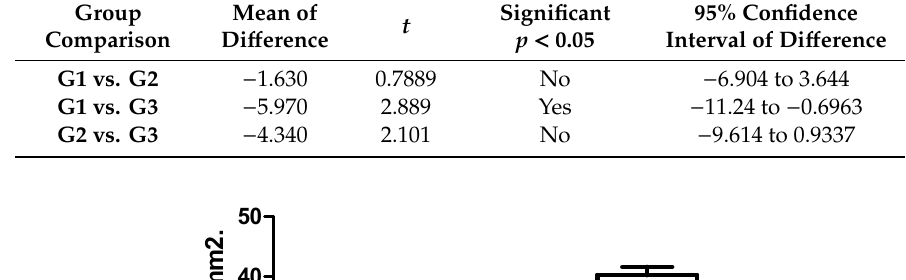
Table 5. Bonferroni's multiple comparison test to compare the osteocyte count values between the groups.